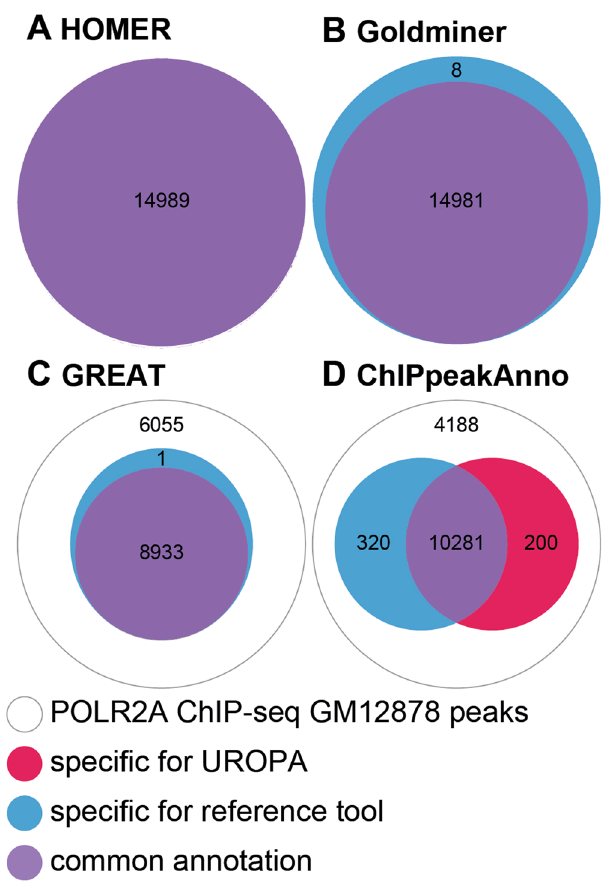
Figure 4. Global comparison of UROPA to other peak annotation tools. White circles represent peaks without any annotation, blue circles represent the number of peaks exclusively annotated by the respective tool, red circles represent peaks exclusively annotated by UROPA, and violet circles represent peaks annotated by both tools. ( A ) Comparison of UROPA and Homer, no tool specific peaks are reported. ( B ) Comparison of UROPA and Goldminer. ( C ) Comparison of UROPA and GREAT. ( D ) Comparison of UROPA and